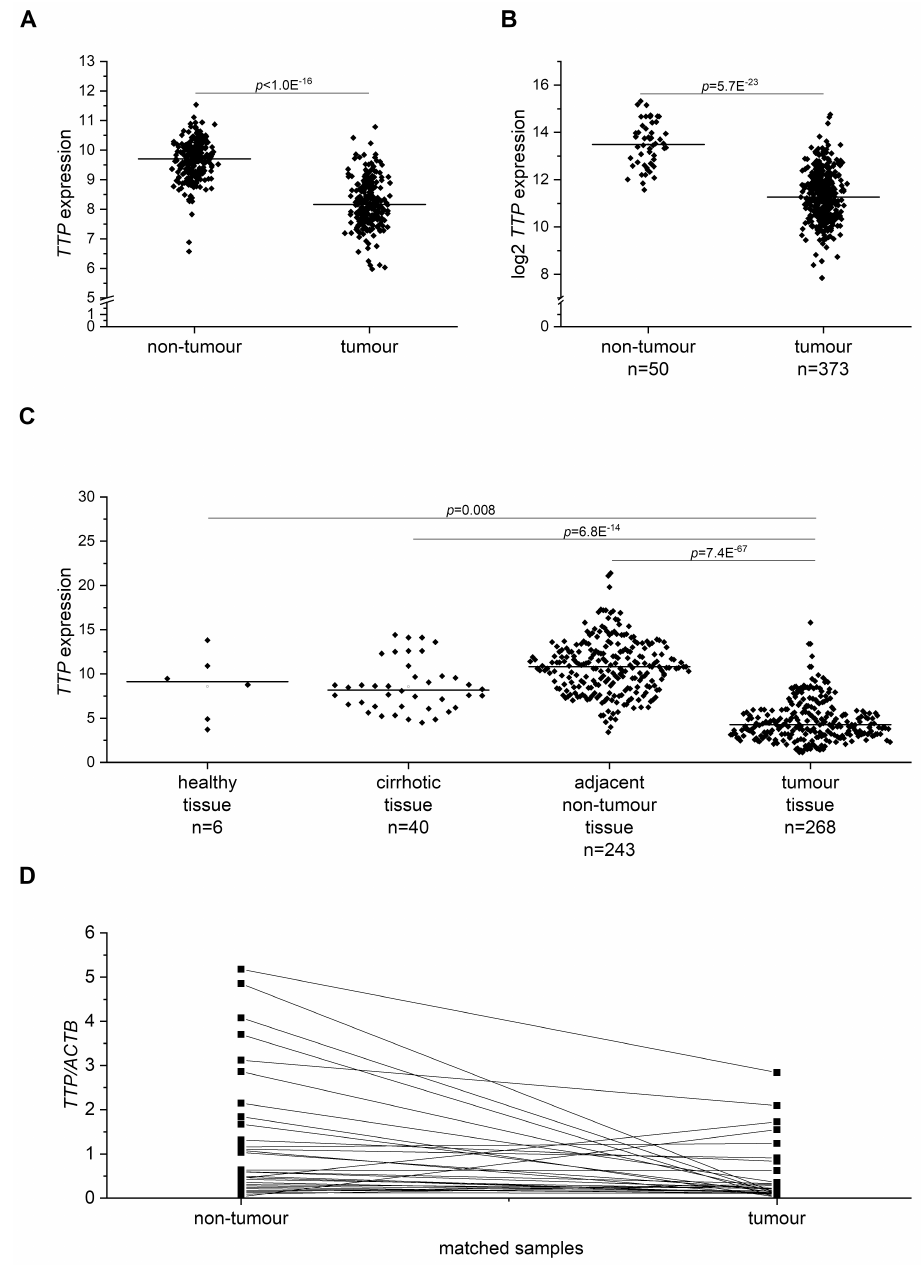
Figure 7. TTP (gene name ZFP36 ) mRNA expression in human tumor and non-tumor liver tissue. ( A ): TTP mRNA expression in 247 human HCC samples relative to the mean of 239 non-tumor liver tissue samples ( µ normal) (GSE14520). ( B ): TTP mRNA expression in tumor ( n = 373) and non-tumor ( n = 50) tissue (The Cancer Genome Atlas (TCGA)). ( C ): TTP mRNA expression in healthy, cirrhotic, adjacent non-tumor, and tumor liver tissues (500 samples; GSE25097). ( D ): TTP mRNA levels isolated of tumor and matched adjacent non-tumor tissues ( n = 31).